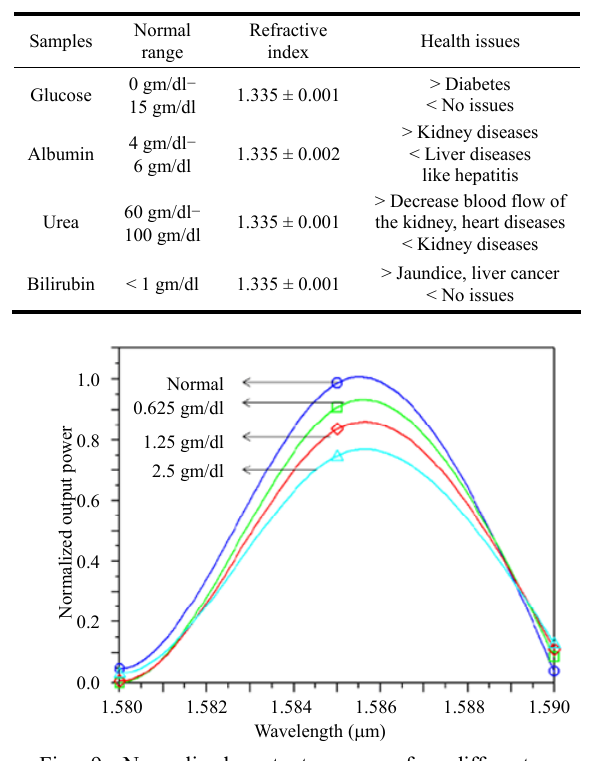
Table 4 Health issues for different glucose, albumin, urea, and bilirubin concentrations present in urine.